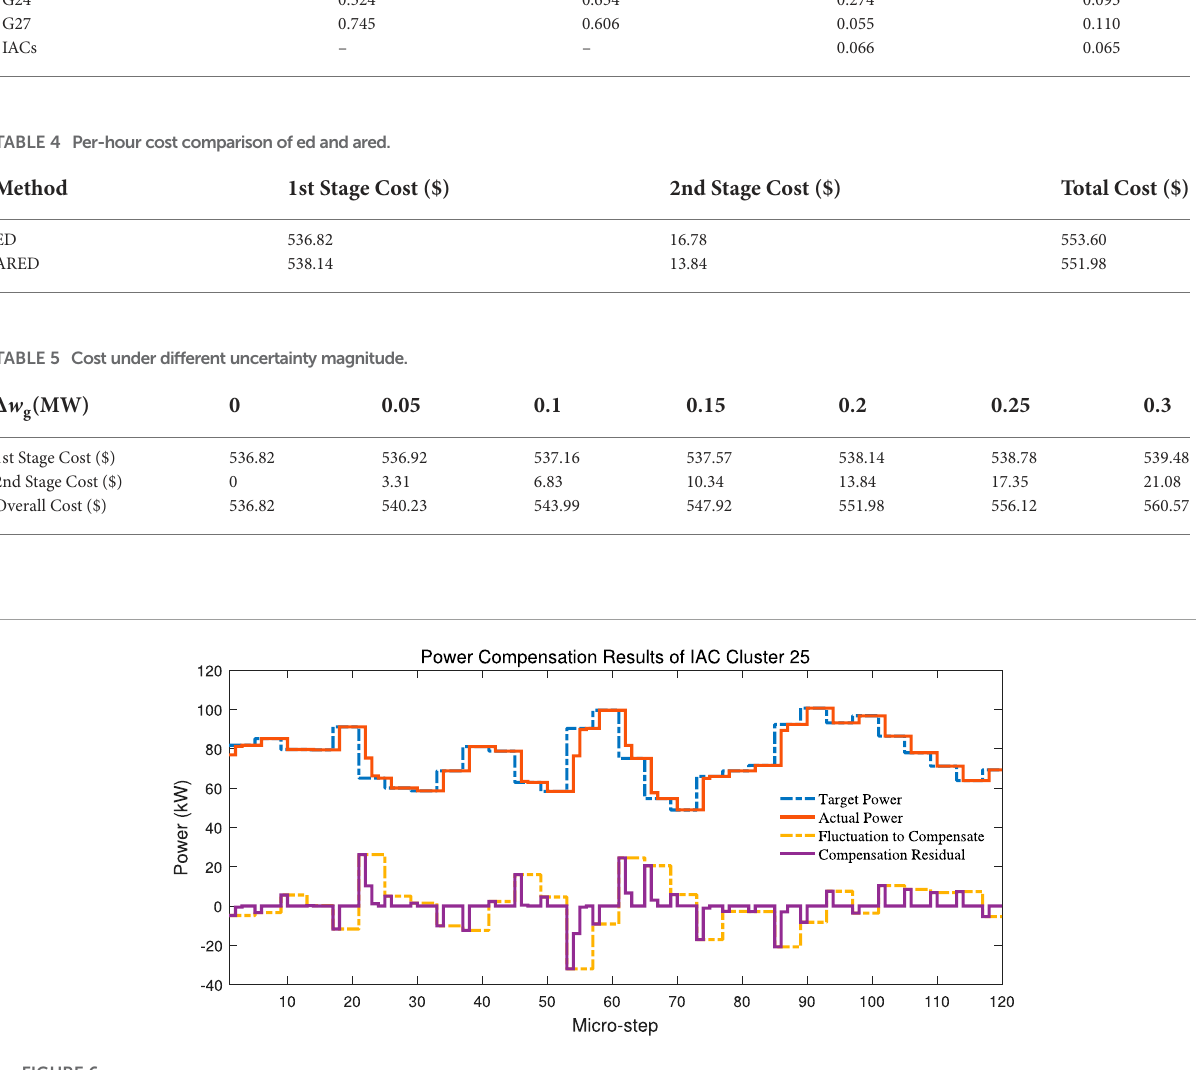
FIGURE 6 Compensation of wind power